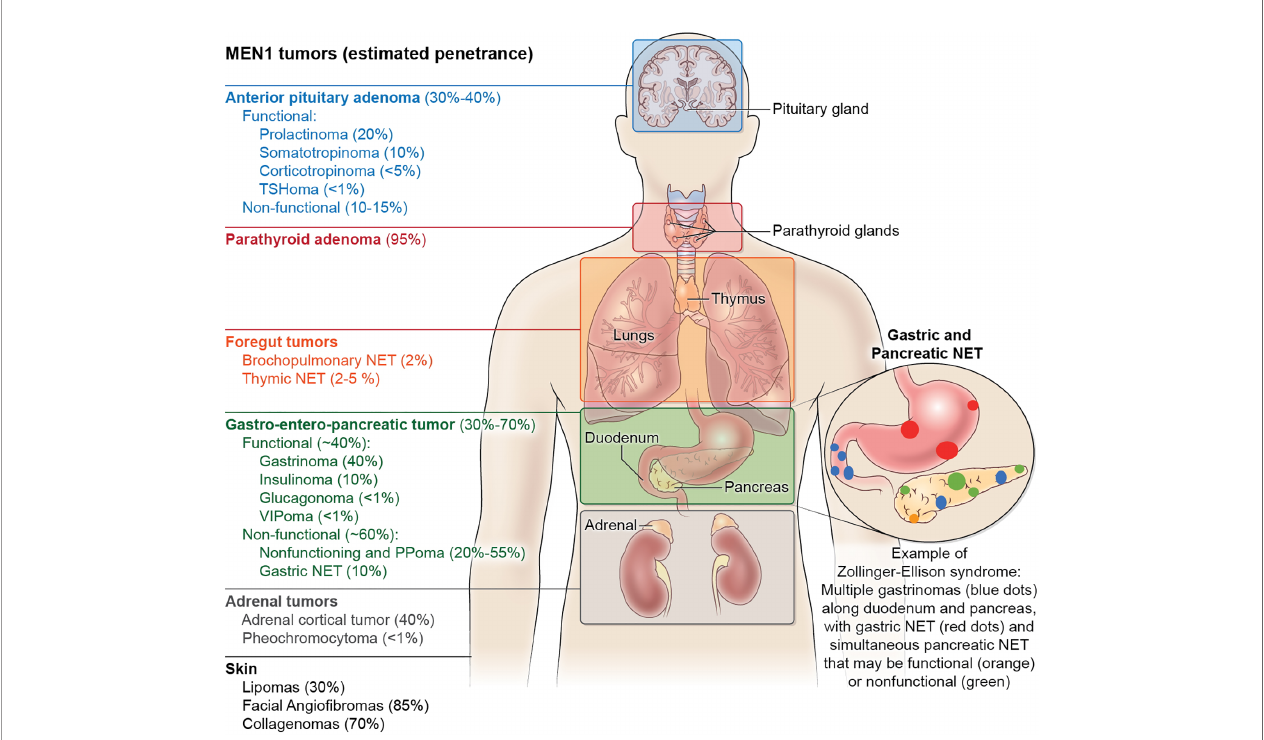
FIGURE 1 | The clinical manifestations and estimated tumor penetrance of multiple endocrine neoplasia type 1 (MEN1) syndrome. The main manifestations of MEN1 include anterior pituitary adenomas, pancreatic neuroendocrine tumors, and primary hyperparathyroidism. Except for multi-gland hyperparathyroidism which approximates 95% penetrance by age 50, the manifestations of other tumors in MEN1 have no genotype-phenotype correlation and cannot be predicted, even within kindreds. Neuroendocrine tumor (NET) hormone secretion in the anterior pituitary and pancreas can be considered functional or non-functional, while duodenal NET and parathyroid adenomas are always functional with the secretion of gastrin and parathyroid hormone, respectively. As pictured, Zollinger-Ellison Syndrome can present with multiple submucosal duodenal gastrinomas with simultaneous pancreatic gastrinomas, non-functional pancreatic tumors, as well as the development of gastric NET typically within thickened gastric folds (not pictured). Less frequent manifestations of MEN1 include foregut bronchopulmonary and thymic neuroendocrine tumors, as well as adrenal cortical adenomas and pheochromocytomas. Skin manifestations of MEN1 include lipomas that can occur anywhere on the body, collagenomas mostly on the trunk, and facial angio fi bromas on the nasal bridge and cheeks. Manifestations that have been described but are not pictured include meningiomas, leiomyoma (uterus, esophagus, ureter, bladder), cafe ́ -au-lait spots, and malignant breast